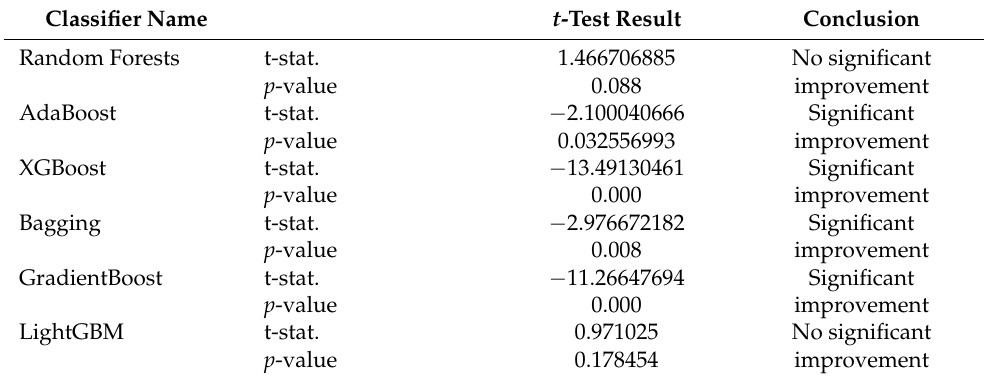
Table 14. The reported p values for